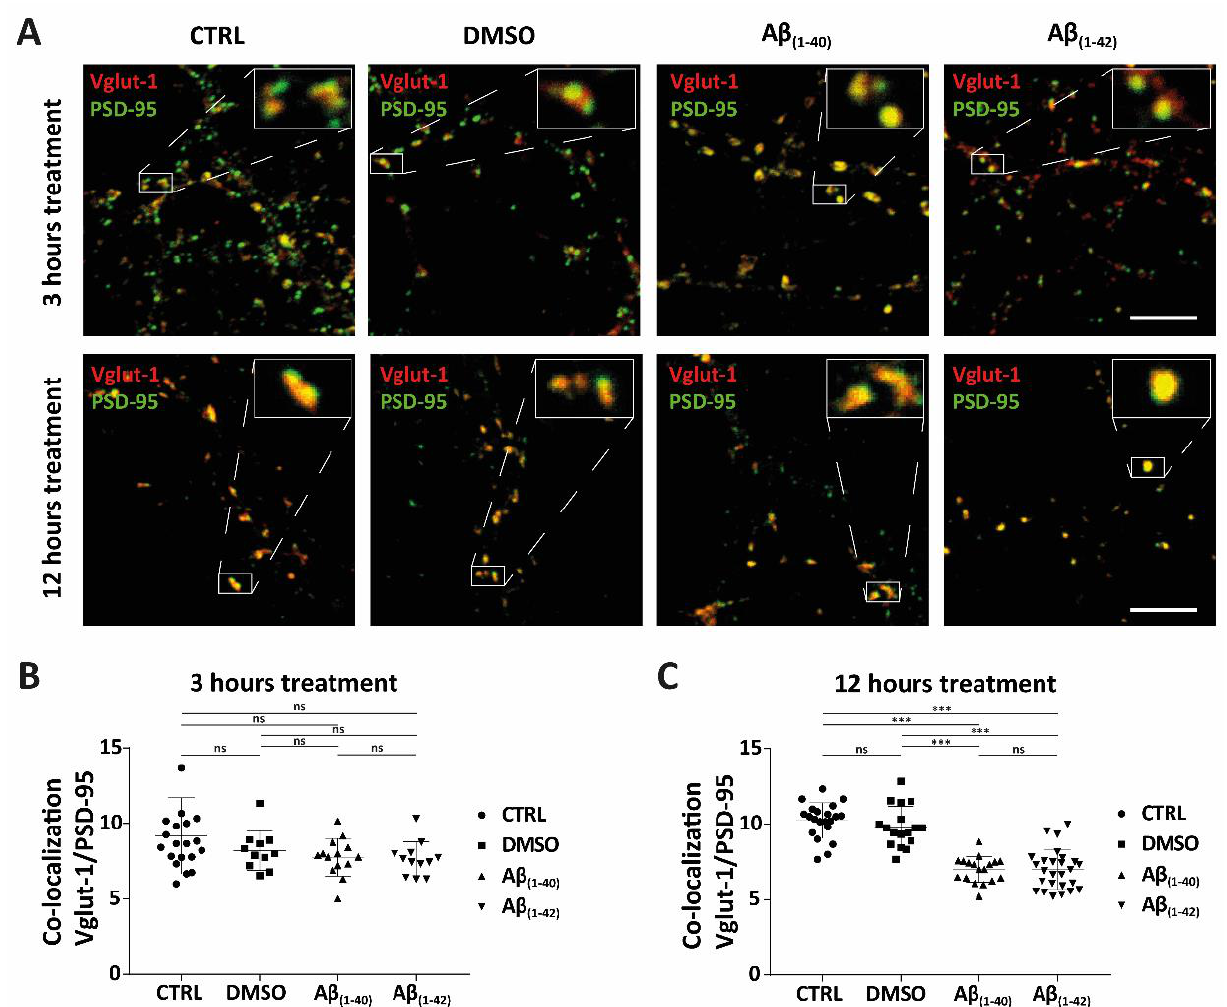
Figure 1 . Synaptic loss of active synapses of Aβ accumulation in hippocampal neurones . ( A – C ) The synaptic study showed the colocalisation of presynaptic (Vglut-1) and postsynaptic (PSD-95) markers, which was defined as active synapses, in hippocampal neurones at DIV12 for both control groups (CTRL and DMSO) and Aβ-treated groups ((1 µM) Aβ (1–40) and (1 µM) Aβ (1–42) ) at different time points (3 h and 12 h) of treatment (all groups from four independent cultures (N = 4)). In the 3 h treatment, the following average number of neurones was counted in each group: CTRL (n = 12), DMSO (n = 9), Aβ (1–40) (n = 11) and Aβ (1–42) (n = 9). In the 12 h treatment, the following average number of neurones was counted in each group: CTRL (n = 14), DMSO (n = 13), Aβ (1–40) (n = 13), and Aβ (1–42) (n = 17). For both 3 h and 12 h treatments, 3 ROI from each neurone was counted. ( A ) Representative confocal images of control groups and Aβ-treated groups of hippocampal neurones stained for both presynaptic (Vglut-1) and postsynaptic markers (PSD-95) are shown. There was a reduction in active synapses after 12 h of Aβ (1–40)- and Aβ (1–42) -treated neurones compared to control groups. White boxes show enlargements of an example of defined active synapses for both control groups and Aβ-treated groups (3 h and 12 h). ( B , C ) Quantification of active synapses from control- and Aβ - treated groups of hippocampal neurones. ( B ) No significant effect on active synapses was seen in Aβ-treated groups after 3 h (3 ROI of average counted cells; n = 10, from four independent cultures (N = 4)). ( C ) A significant reduction of active synapses was observed after 12 h of Aβ (1–40) - and Aβ (1–42) -treated neurones compared to control groups. No significance (ns) was seen between CTRL and DMSO, nor between Aβ (1–40) - and Aβ (1–42) -treated neurones (3 ROI of average counted cells; n = 14, from four independent cultures (N = 4)). *** p < 0.0001; scale bars represent 5 µm. The size of the ROI was 47 µm 2 .